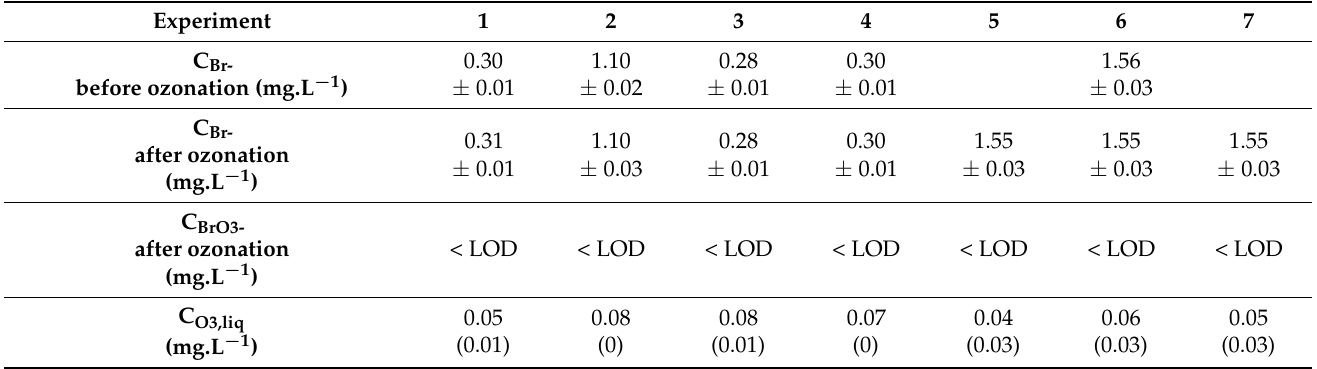
Table 7. Concentrations of bromides, bromates and residual ozone before and after the different